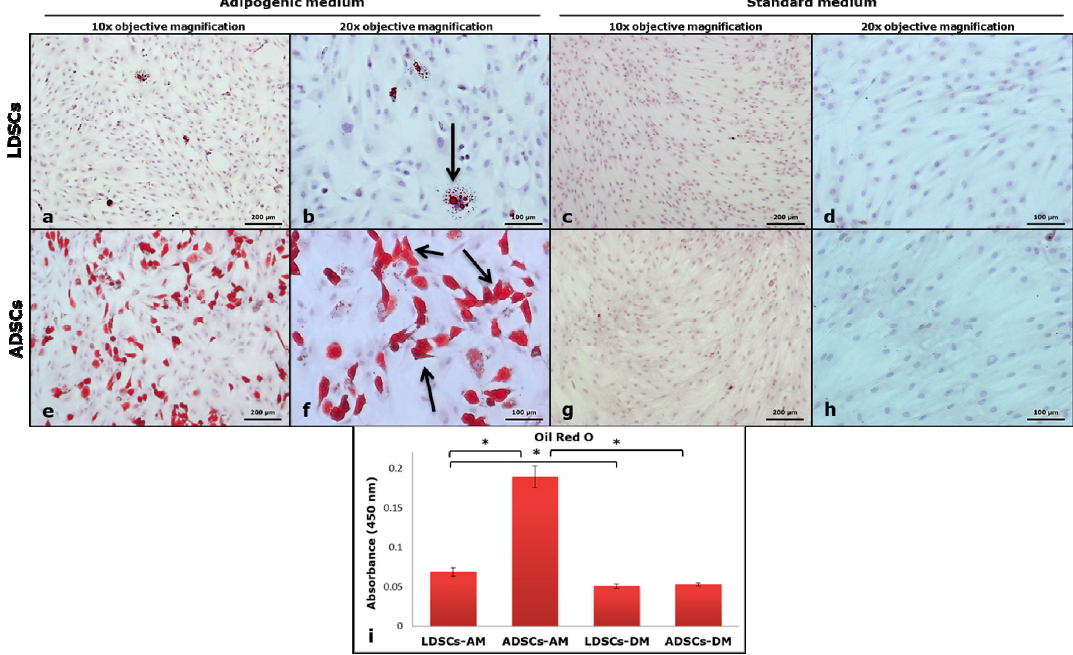
Figure 5. Oil red O staining of cells after 21 day of adipogenic differentiation; LDSCs in adipogenic